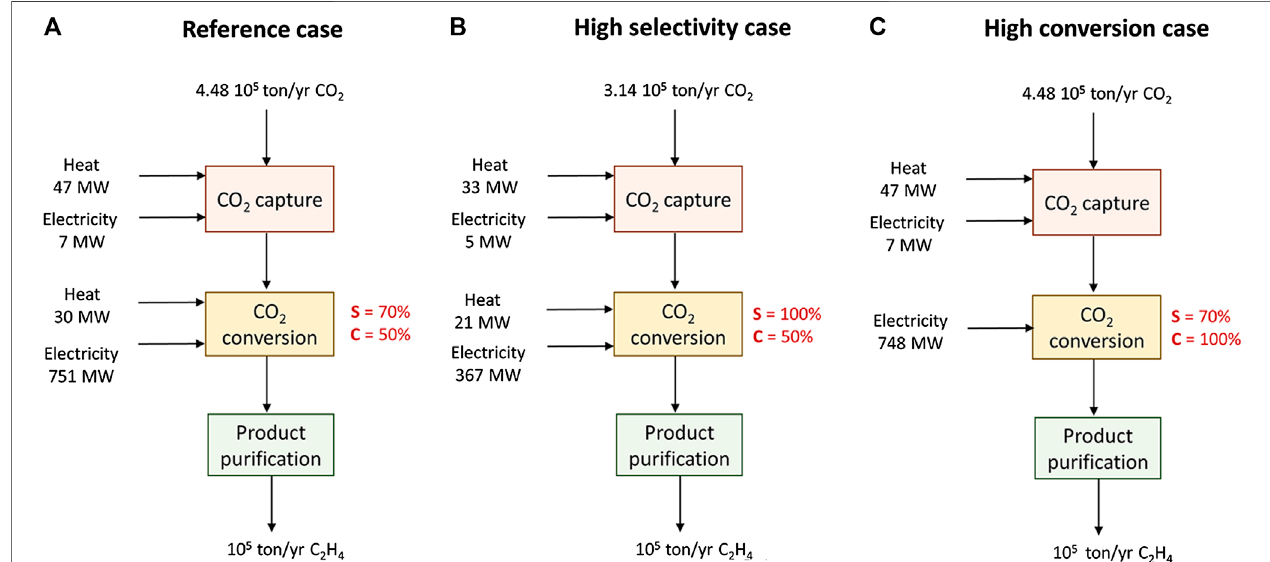
FIGURE 6 | Black box representations of the electrochemical reduction of CO 2 with the electrolyzer performance, i.e., conversion (C) and selectivity (S), energy inputandmaterialstreamsthathavebeenconsideredintheeconomicanalysisforthe (A) reference,highCO 2 costandfreeelectricitycases, (B) thehighselectivitycase, and (C) the high conversion